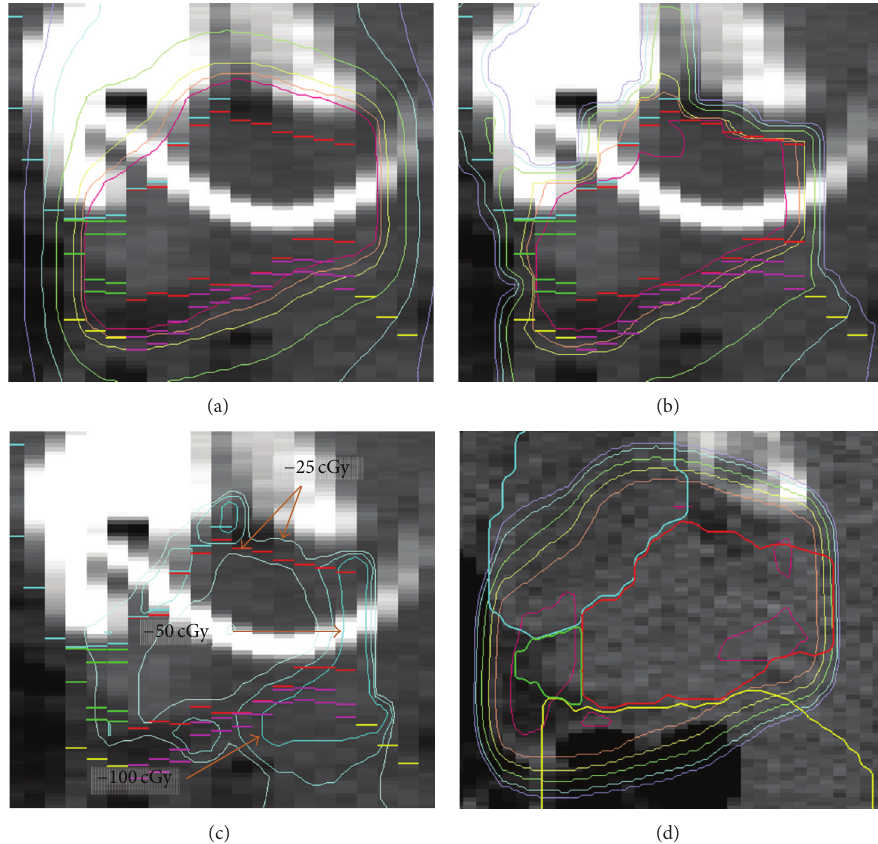
Figure 6: Organ contours and isodose curves on midsagittal slices for a typical case. Organs shown are the prostate (red), seminal vesicles (green), bladder (blue), rectum (yellow), and anterior rectal wall (purple). (a) Planned isodoses on pCT. (b) Cumulative isodoses on pCT. (c) Error dose on pCT. (d) Delivered isodoses computed from one